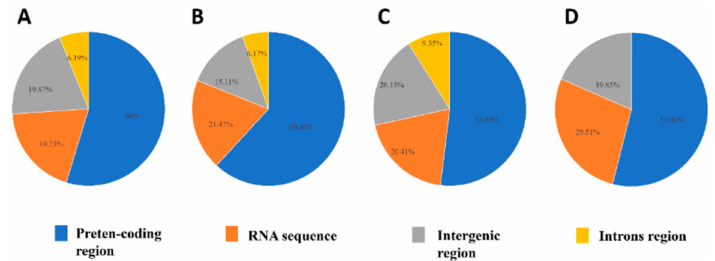
Figure 4. The proportion of the mitogenomes comprised by protein-coding, intronic, intergenic, and RNA genes (tRNA and rRNA) for four Clonostachys species. (( A – D ): C. compactiuscula , C. rogersoniana , C. solani , Clonostachys